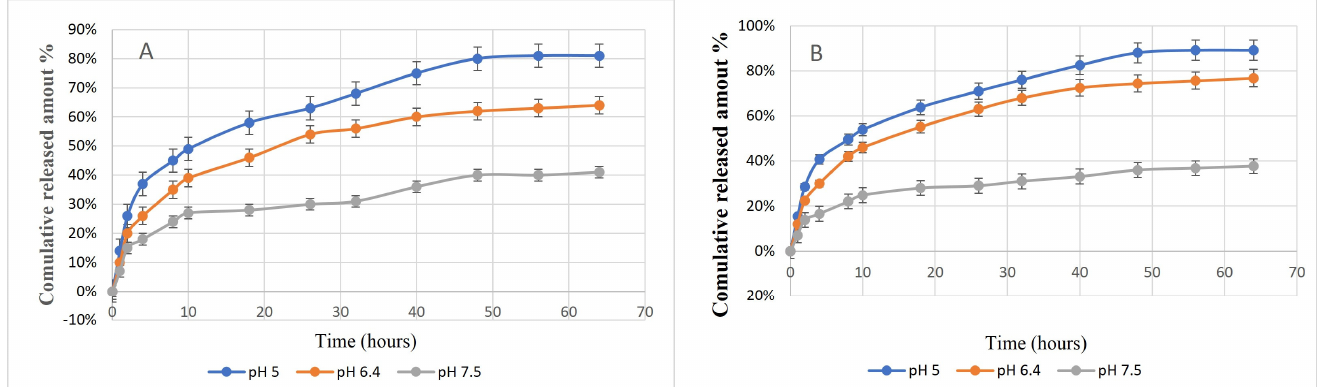
Figure 2. In vitro release profile of GM ( A ) and AA ( B ) from CSNPs at different pH values.